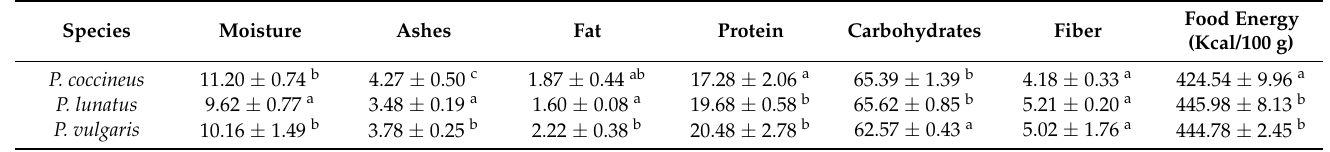
Table 2. Proximate analysis by Phaseolus species (% w / w